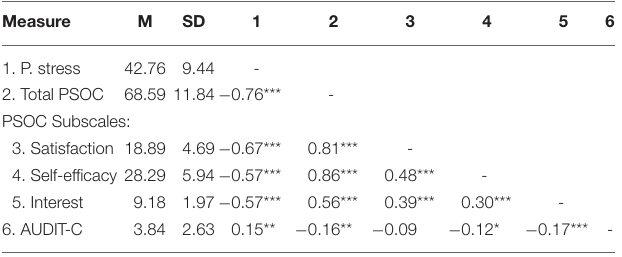
TABLE 4 | Descriptive statistics and Pearson’s correlation coefficients. Measure